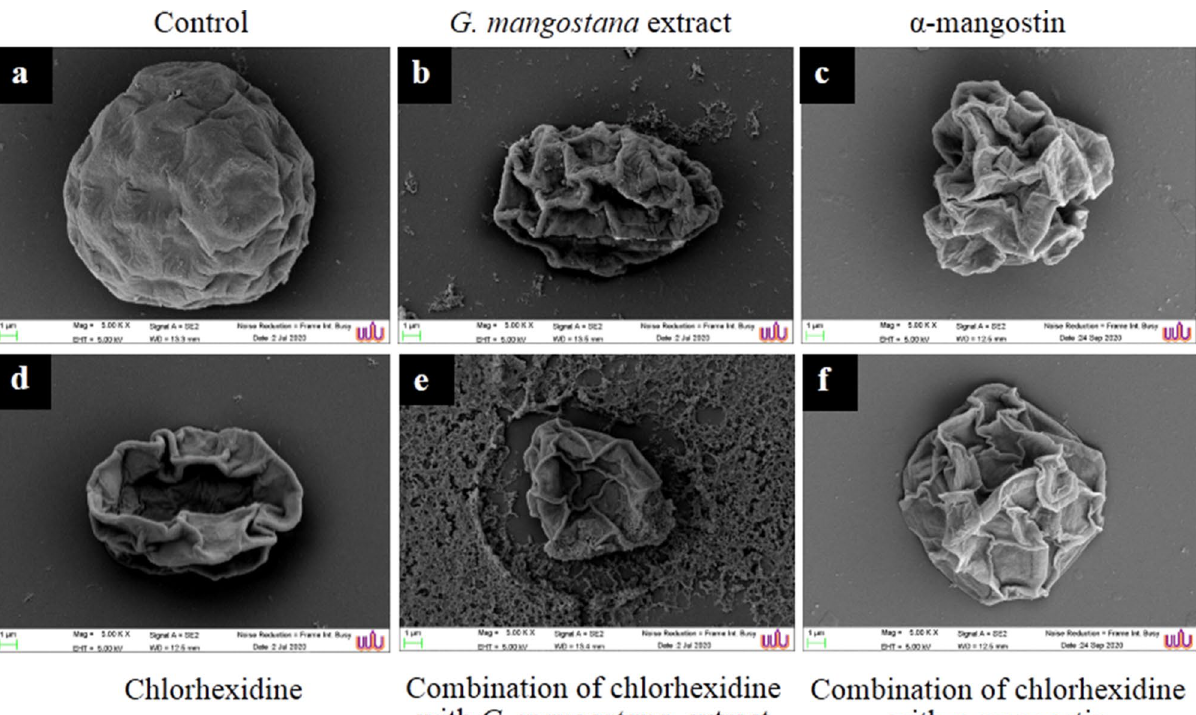
Figure 7. Scanning micrographs of A. triangularis cysts after treatment with G. mangostana extract, chlorhexidine, α-mangostin and in combination at 24 h. Control cysts ( a ), cysts were treated with G . mangostana extract (16 mg/mL) ( b ), α-mangostin (4 mg/mL) ( c ), chlorhexidine (2.56 mg/mL) ( d ), and combination of chlorhexidine (0.004 mg/mL) and G. mangostana extract (0.5 mg/mL) ( e ), combination of chlorhexidine (0.04 mg/mL) and α-mangostin (0.062 mg/mL) ( f ). Magnification: ( a – f ) = ×